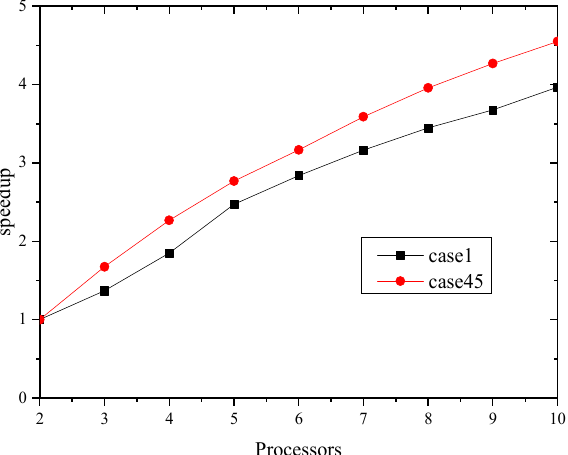
Table 3. Computational time of DGA (s).